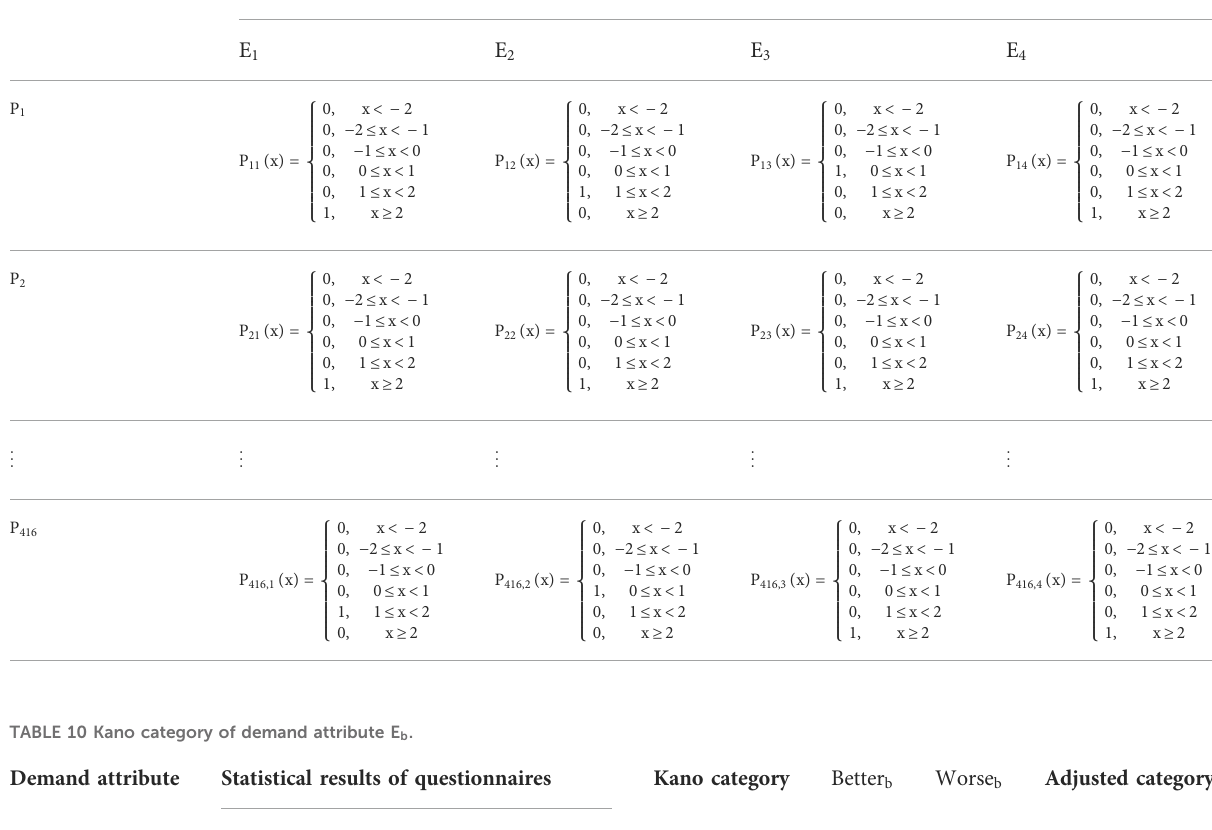
TABLE 9 Attribute value in the form of multi-granularity sentiment strength distribution. Demand document